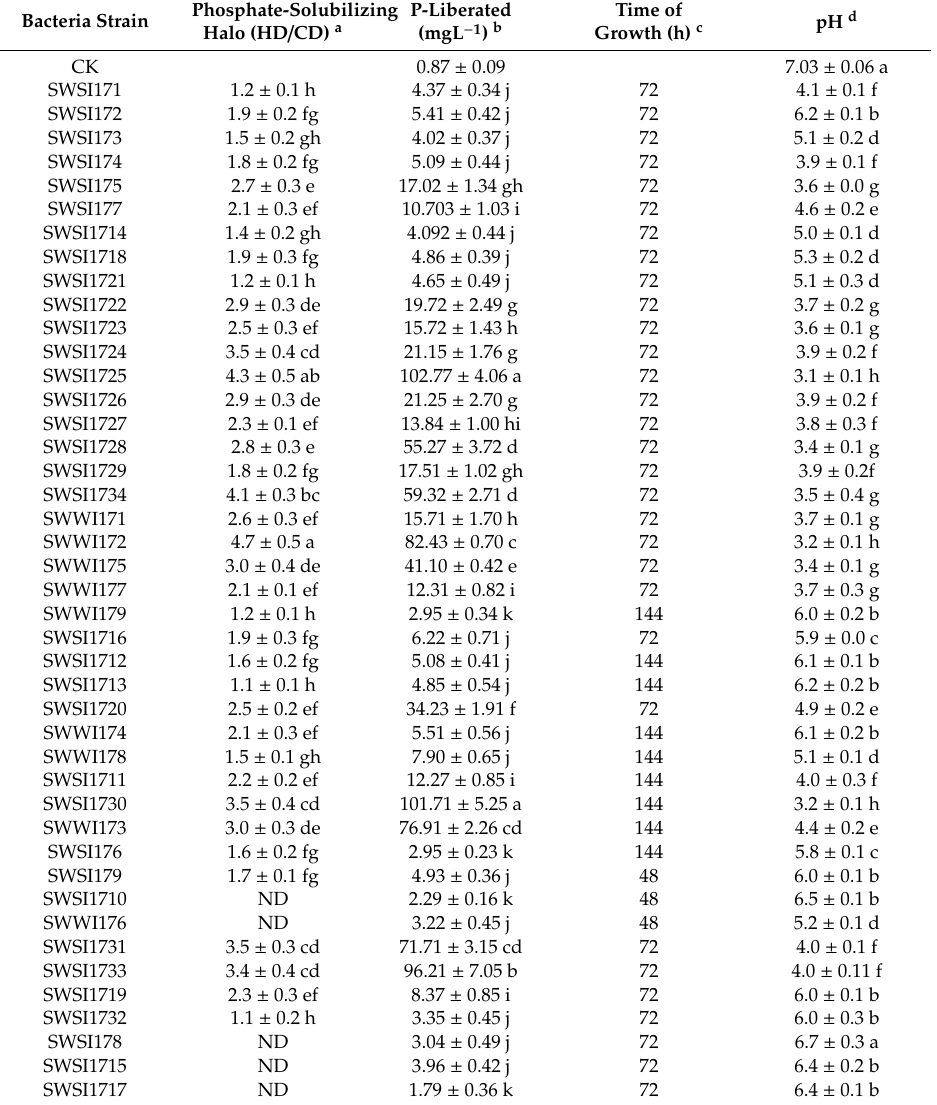
Table 2. The Phosphate-solubilizing halo, maximum amounts of P-liberated, pH, and time of growth. Bacteria